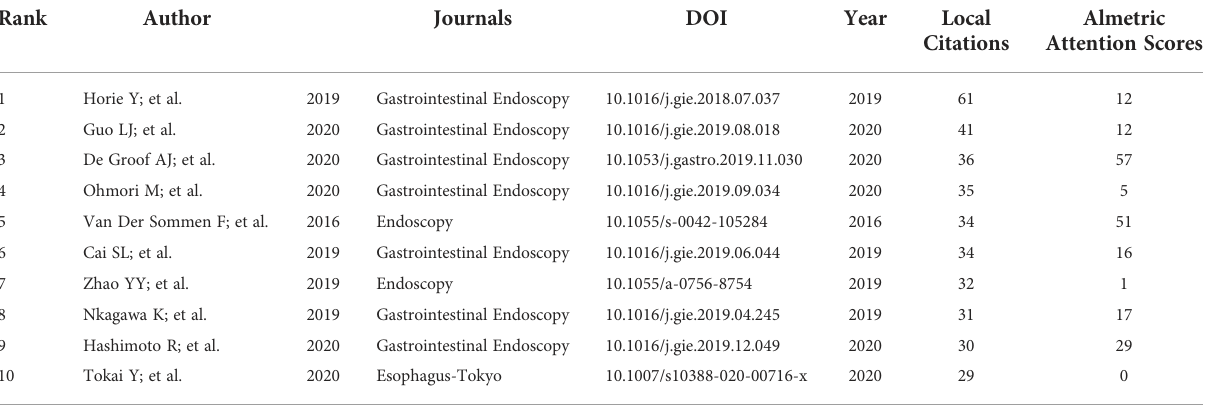
TABLE 4 Top 10 local cited documents concerning the research of AI on